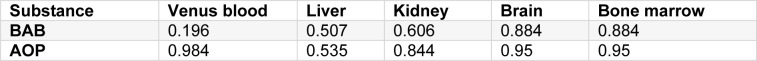
Calculated steady state concentrations in tissues [µmol/L] for AOP and BAB, respectively, against 1 mg/m³ air exposure.